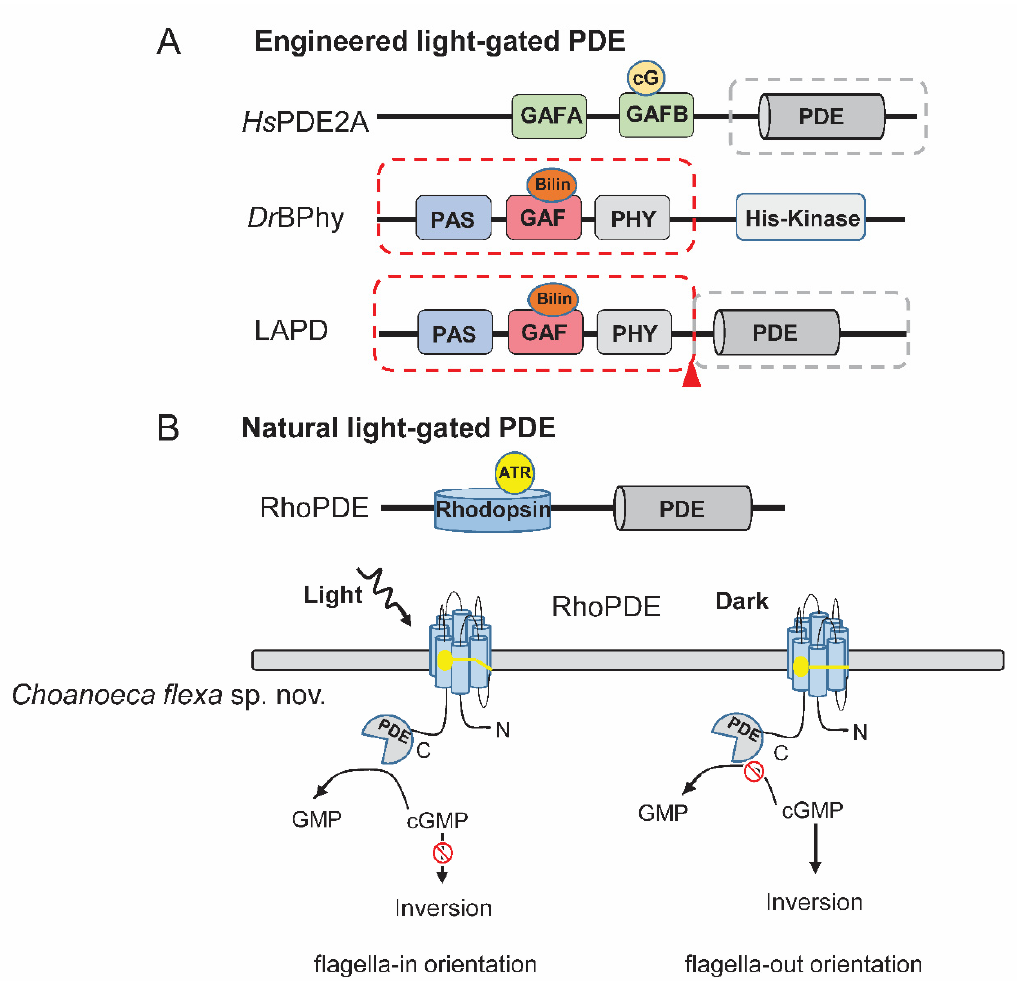
Figure 3. Engineered and natural light-gated PDEs. ( A ) The schematic model of generating the artificial light-gated PDE, LAPD. The LAPD comprises the light sensor modules from Dr BPhy (labeled by red dashed box) and PDE catalytic domain from Hs PDE2A (labeled by gray dashed box). The encircled cG indicates cGMP. The chromophore is shown with encircled Bilin. The red triangle indicates the connection point. ( B ) The schematic model of natural light-gated PDE. The chromophore is shown with encircled ATR. In a newly discovered protist Choanoeca flexa sp. nov, the RhoPDE can be activated by light to hydrolyze cGMP and trigger the inversion to flagella-in orientation. In the dark, cGMP levels will be maintained and flagella-out orientation is kept. The lower cartoon in B is made according to [65]. LAPD: light-activated PDE; Bilin: biliverdin; PAS: Per-Arnt-Sim domain; ATR: all-trans-retinal.